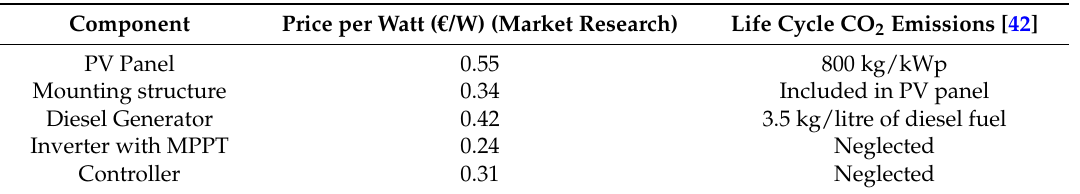
Table 2. Prices of the used